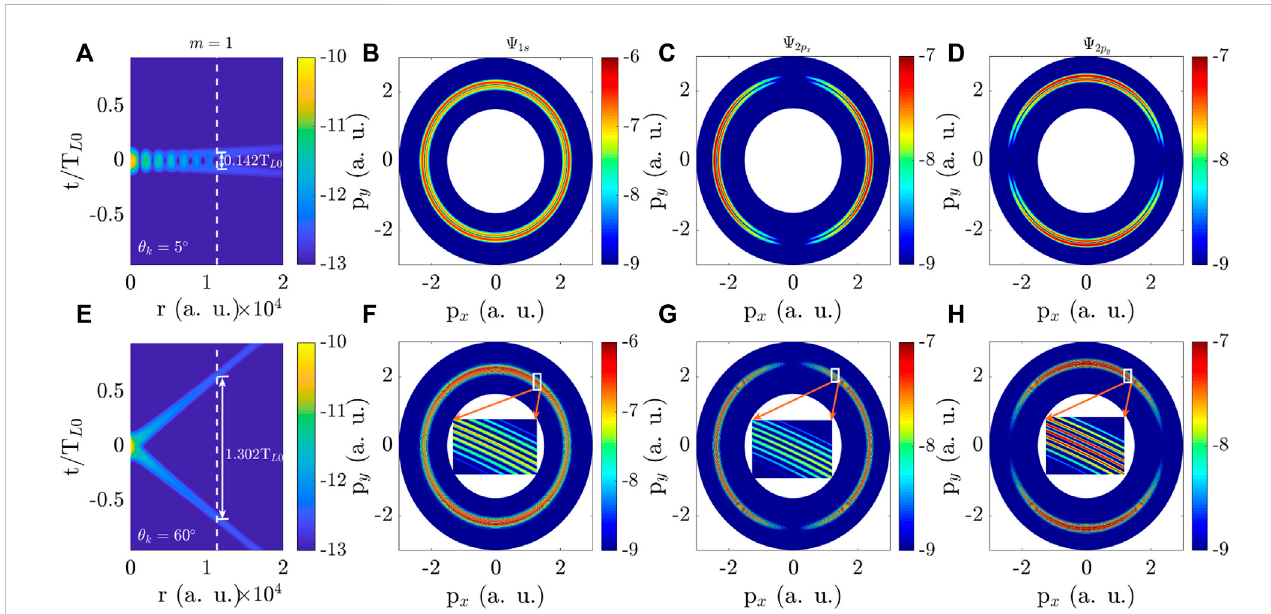
FIGURE 3 PMDs of an atom bythetwisted X wavepulseat r = ( r , ϕ r =0, z = 0).Moduliofthe Xwave vector potential as afunction of thedistance r to beam axisand time t for thePTAM m =1 and twovalues oftheopeningangle (A) θ k = 5 ° and (E) θ k = 60 ° on alogarithmic scale. Thetime-delay τ betweenthetwosplit pulses of the X wave at the position r 0 = 11350 a.u. labeled by the white dashed line is labeled by the solid line with double arrows. (B – D) , (F – H) PMDs of 1 s, 2p x and 2p y statesofahydrogenatomattheimpactparameter b =11350a.u.inthe X wavesfor (A) and (E) .Theinsetsin (F – H) showthedetailsofPMDswithinthe area outlined in white. The units of physical quantities in fi gures are